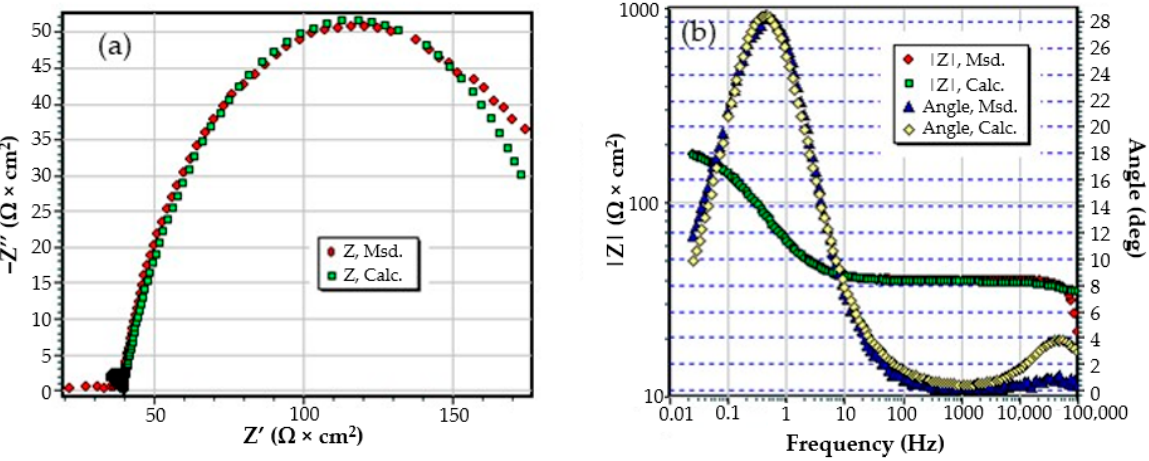
Figure A2. The Nyquist diagram ( a ) and Bode diagram ( b ) for C45 sample after 43 days of immersion in BSW.